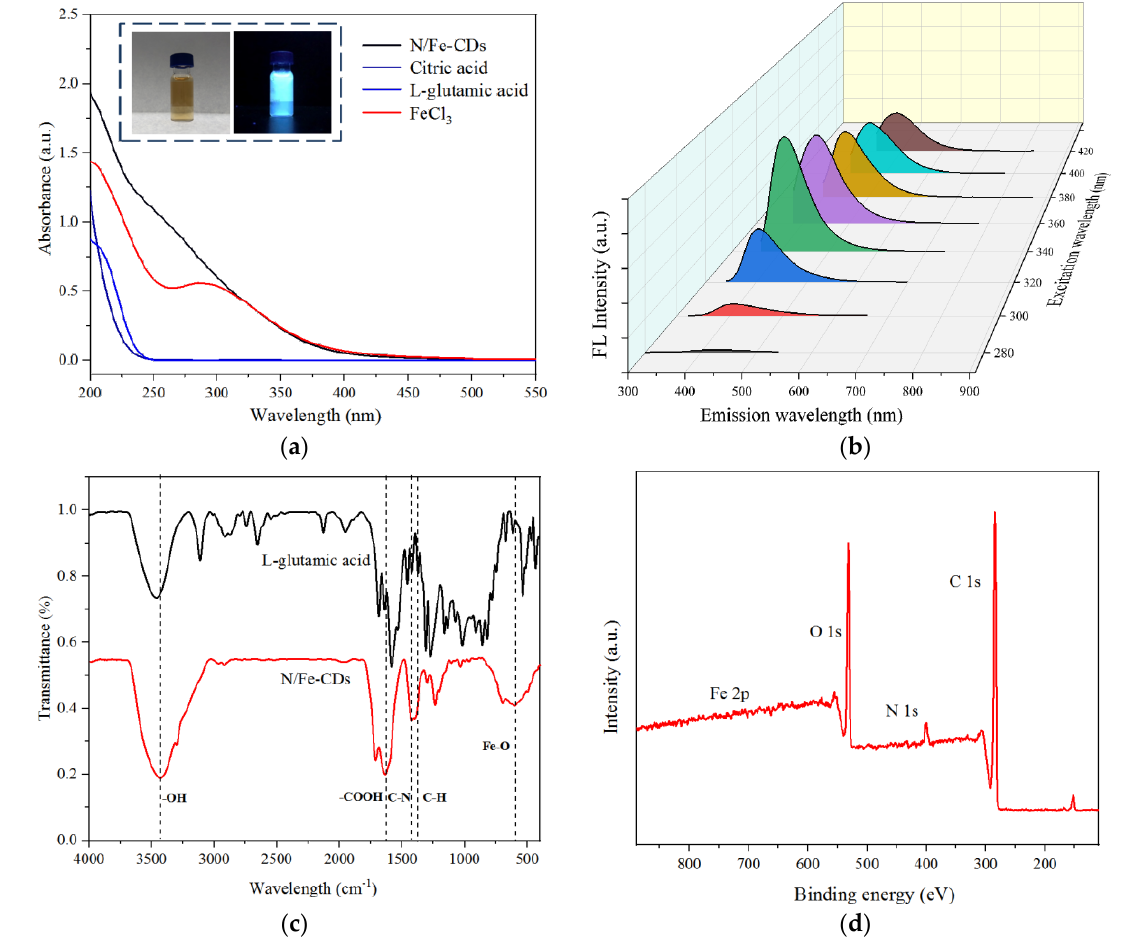
Figure 2. Spectral characteristics of N,Fe-CDs, ( a ) UV-Vis spectra, ( b ) Fluorescence spectra, ( c ) FI-IR spectra, and ( d ) XPS spectra.